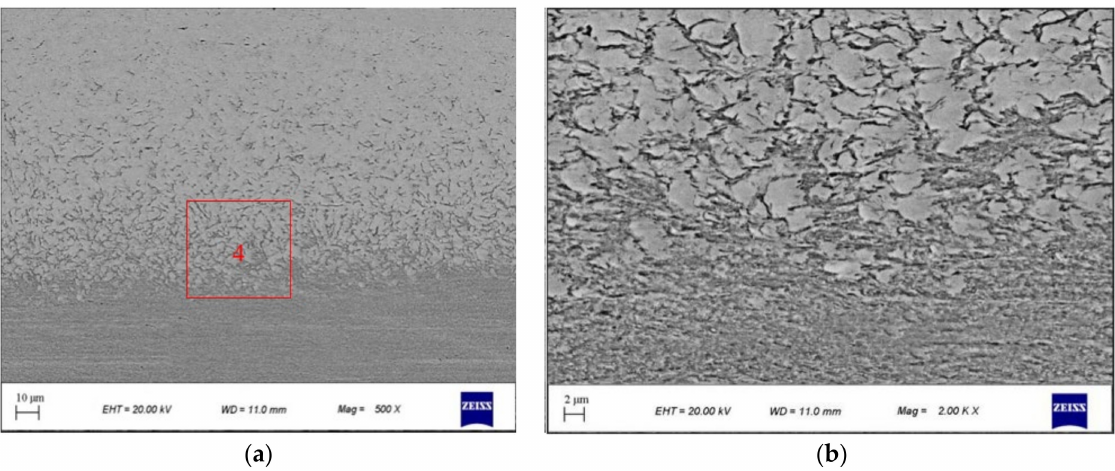
Figure 10. Morphology of transition zone at a scanning speed of 700 mm/min; ( a ) 500 × magnification and ( b ) area 4 at 2000 × magnification.